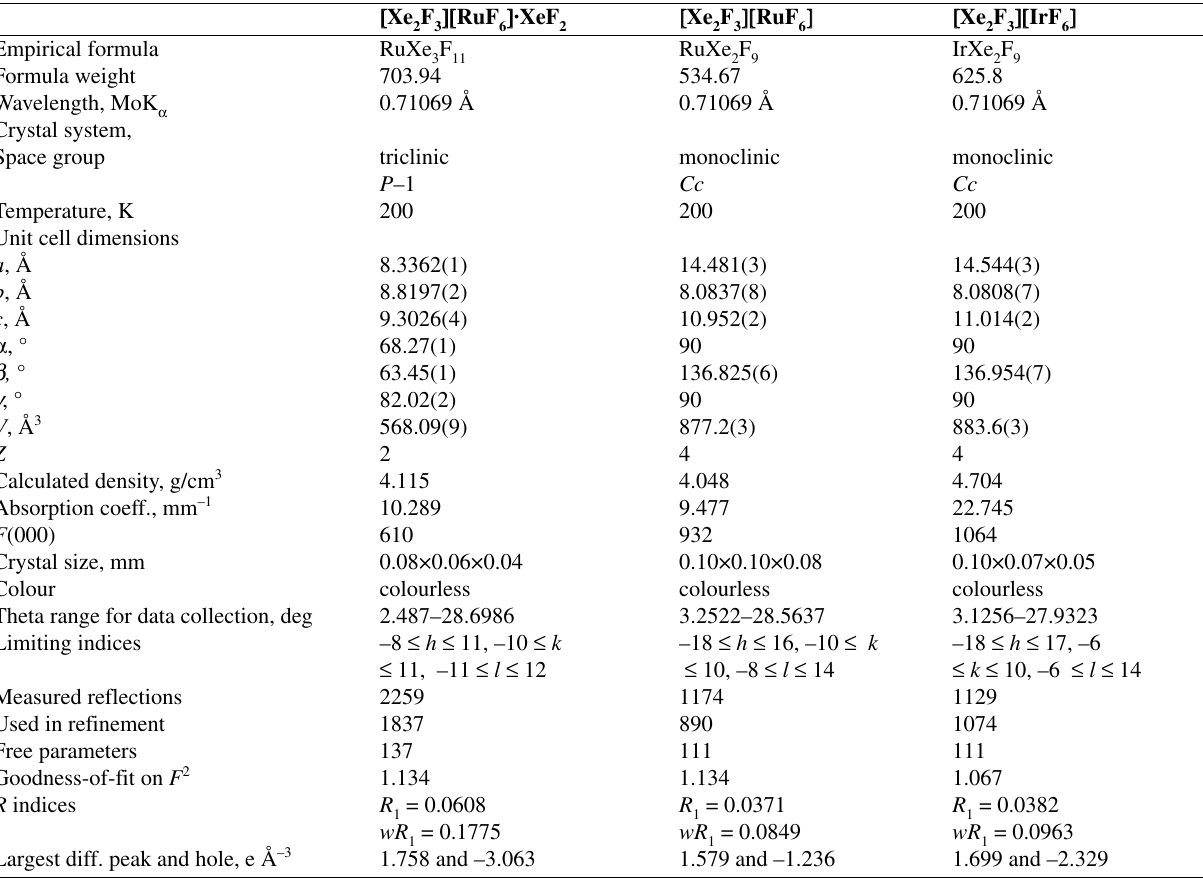
][ RuF ] ·XeF F and Xe 2 3 6 2